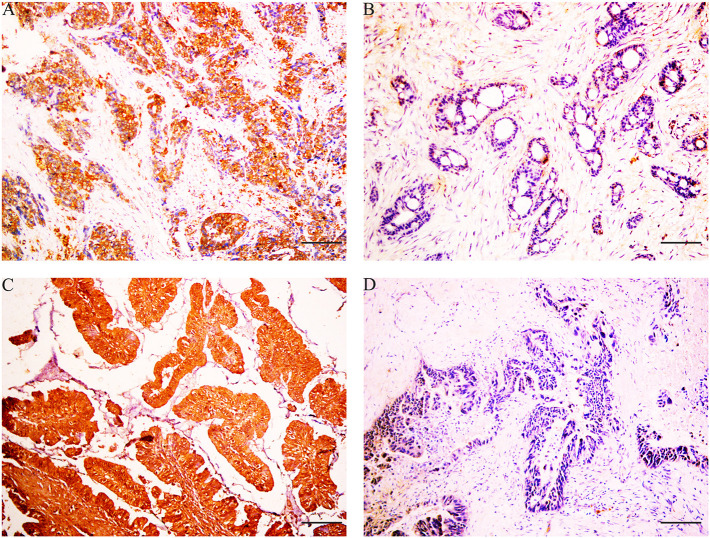
XBP1 and NAT1 expression in gallbladder AC, original magnification ×200. XBP1-positive reactions were localized in the nuclei, and NAT1-positive reactions were localized in the cytoplasm. (A) Positive expression of XBP1 in poorly differentiated AC. (B) Negative expression of XBP1 in well-differentiated AC. (C) Positive expression of NAT1 in well-differentiated AC. (D) Negative expression of NAT1 in moderately differentiated AC. Scale bars: 50 μm.